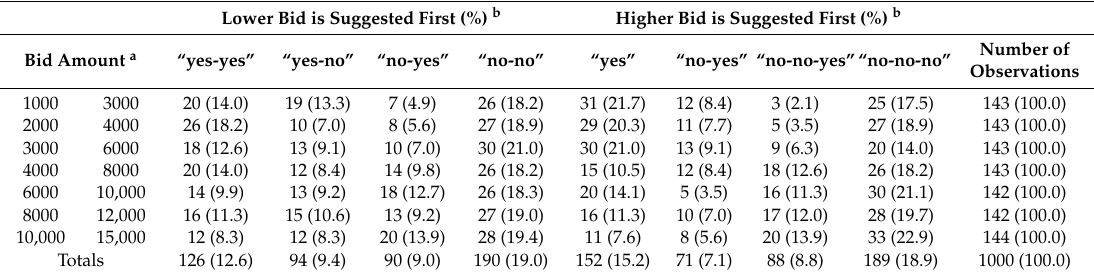
Table 1. Willingness-to-pay data obtained and used in this study. Lower Bid is Suggested First (%) b Higher Bid is Suggested First (%)